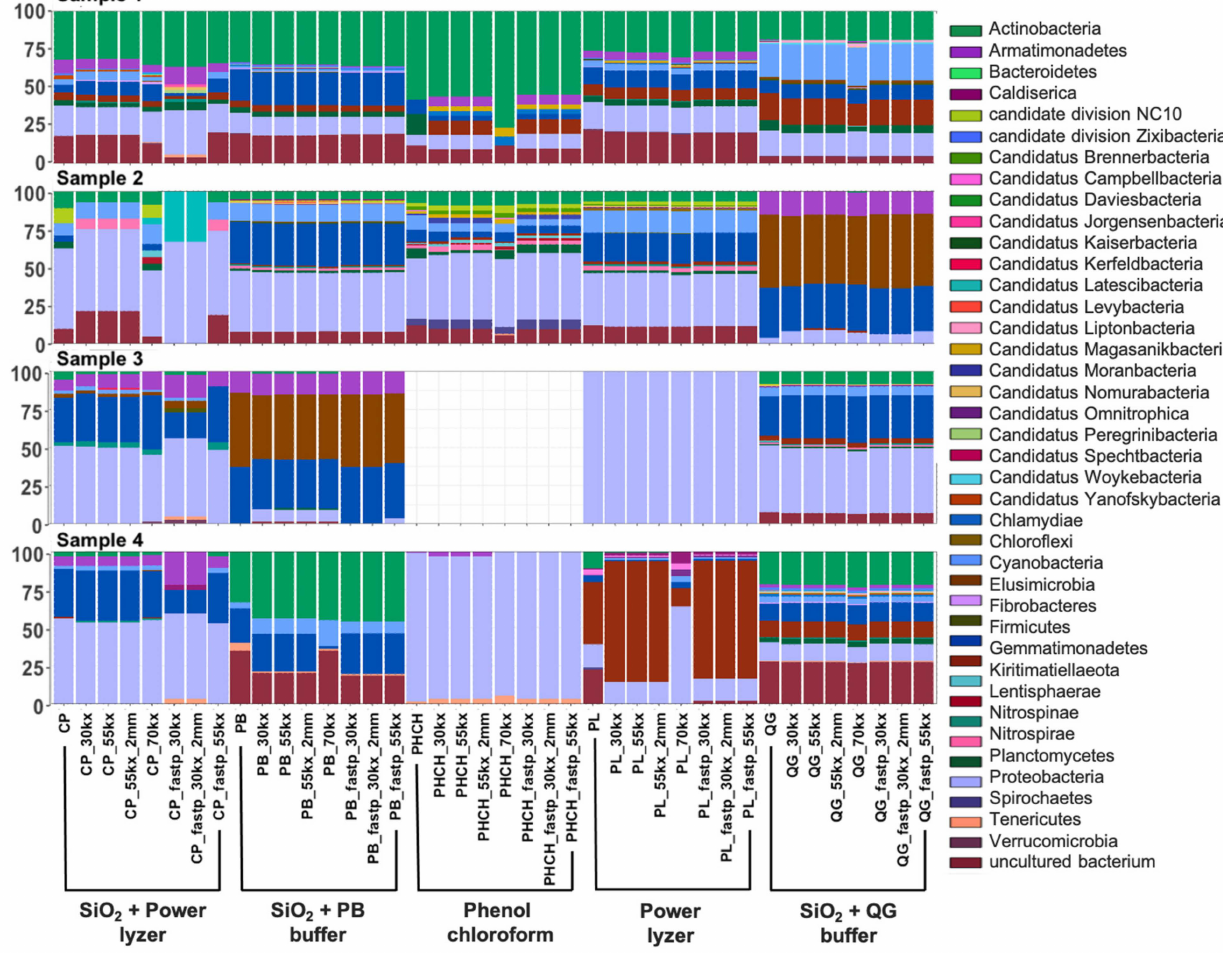
Figure 4. Taxonomic profile for the Bacteria domain at phylum level of collapsed reads of the four samples extracted with five DNA extraction methods and preprocessed using eight bioinformatic pipelines, obtained by aligning collapsed reads to SILVA SSU 132 as reference